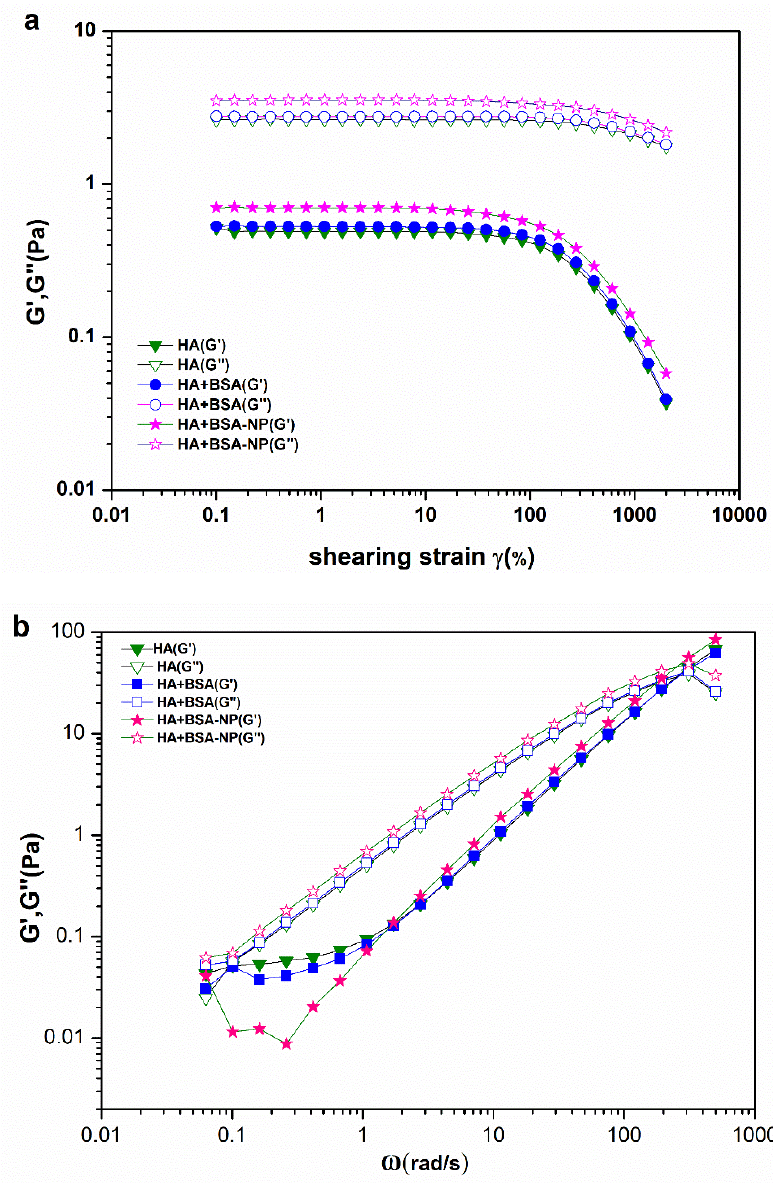
Figure 5. The elastic modulus (G ′ ) and viscous modulus (G ″ ) of HA (15 mg/mL) with or without BSA-NPs and BSA (15 mg/mL): strain scanning ranging from 0.1% to 2000% at a frequency of 6.3 rad/s ( a ); frequency scanning ranging from 0.063 rad/s to 500 rad/s at a strain of 0.5% ( b ).